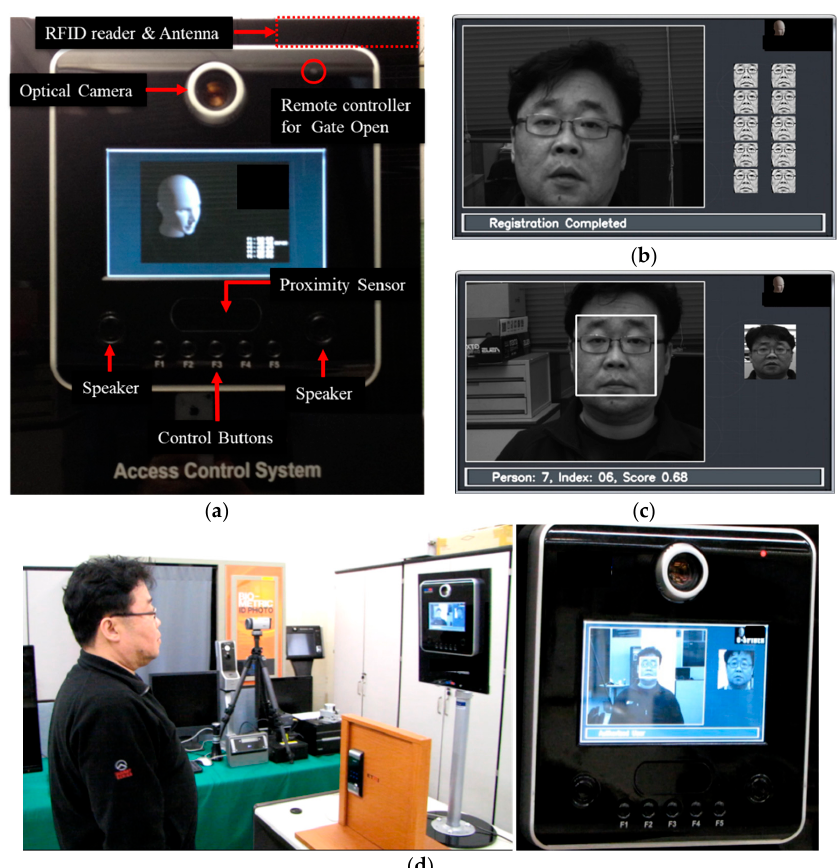
Figure 9. The mockup of the proposed user-friendly, stand-alone access control system based on HFR at a distance with RFID, viz. the BioGate access control system: ( a ) system configuration of the mockup system, ( b ) example of user registration, ( c ) example of user authentication, and ( d ) example of the experimental environment.